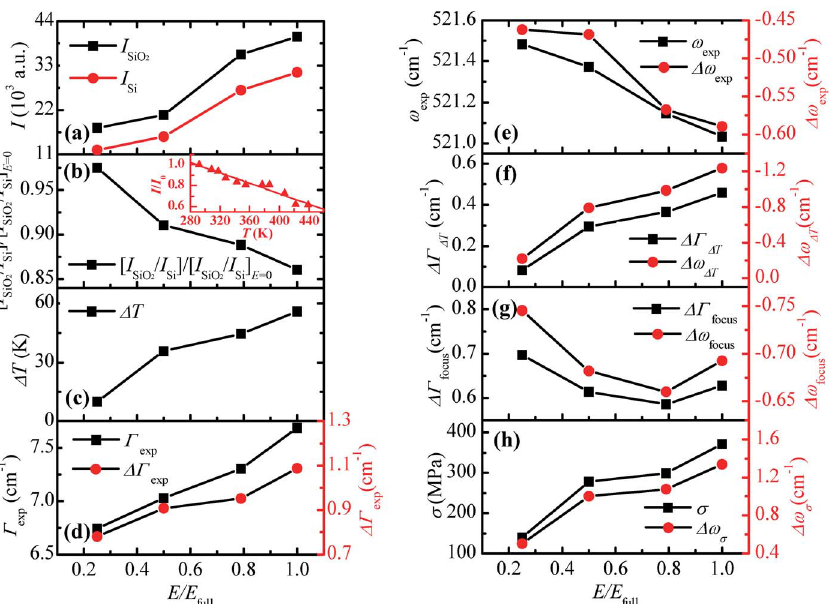
Figure 4. Temperature rise and thermal stress inside silicon under particle-focused laser irradiation. (a) How Raman intensity of silicon ) and that of pure silicon ( I Si ) vary with energy percentage ( E/E full ). (b) Normalized Raman intensity ratio under 1210 nm silica particles ( I SiO 2 = I Si ½ (cid:1) = I SiO = I Si ½ (cid:1) ) and (c) temperature rise ( D T ) versus energy percentage. The inset in figure (b) shows the linear relation between normalized ( I SiO E ~ 0 2 2 Raman intensity of silicon ( I / I 0 ) and temperature with a slope of 2 0.00249 K 2 1 . I 0 is the intensity of silicon at 292.0 K. (d) Raman linewidth and (e) Raman wavenumber of silicon under particles and their differences with those of pure silicon. (f) Raman wavenumber and linewidth changes due to temperature rise. (g) Raman wavenumber and linewidth changes due to out-of-focus effect. (h) Thermal stress ( s ) and Raman wavenumber change induced by stress under different laser energies.